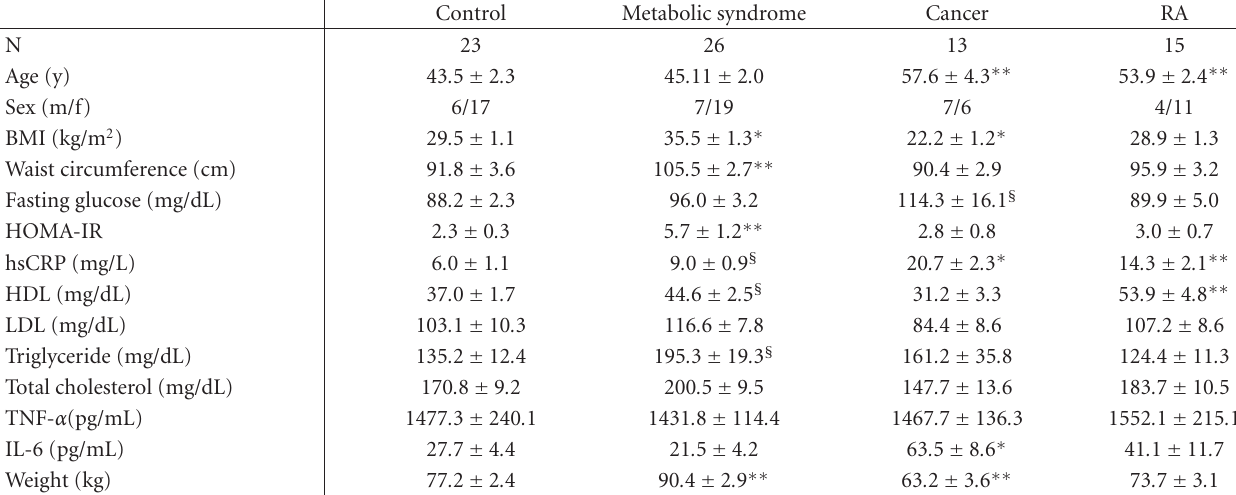
Table 2: Anthropometric and biochemical variables of patients with metabolic syndrome, RA, and cancer. Data were presented as means ± SEM (compared to control, ∗ P < . 001, ∗∗ P < . 01, § P < .